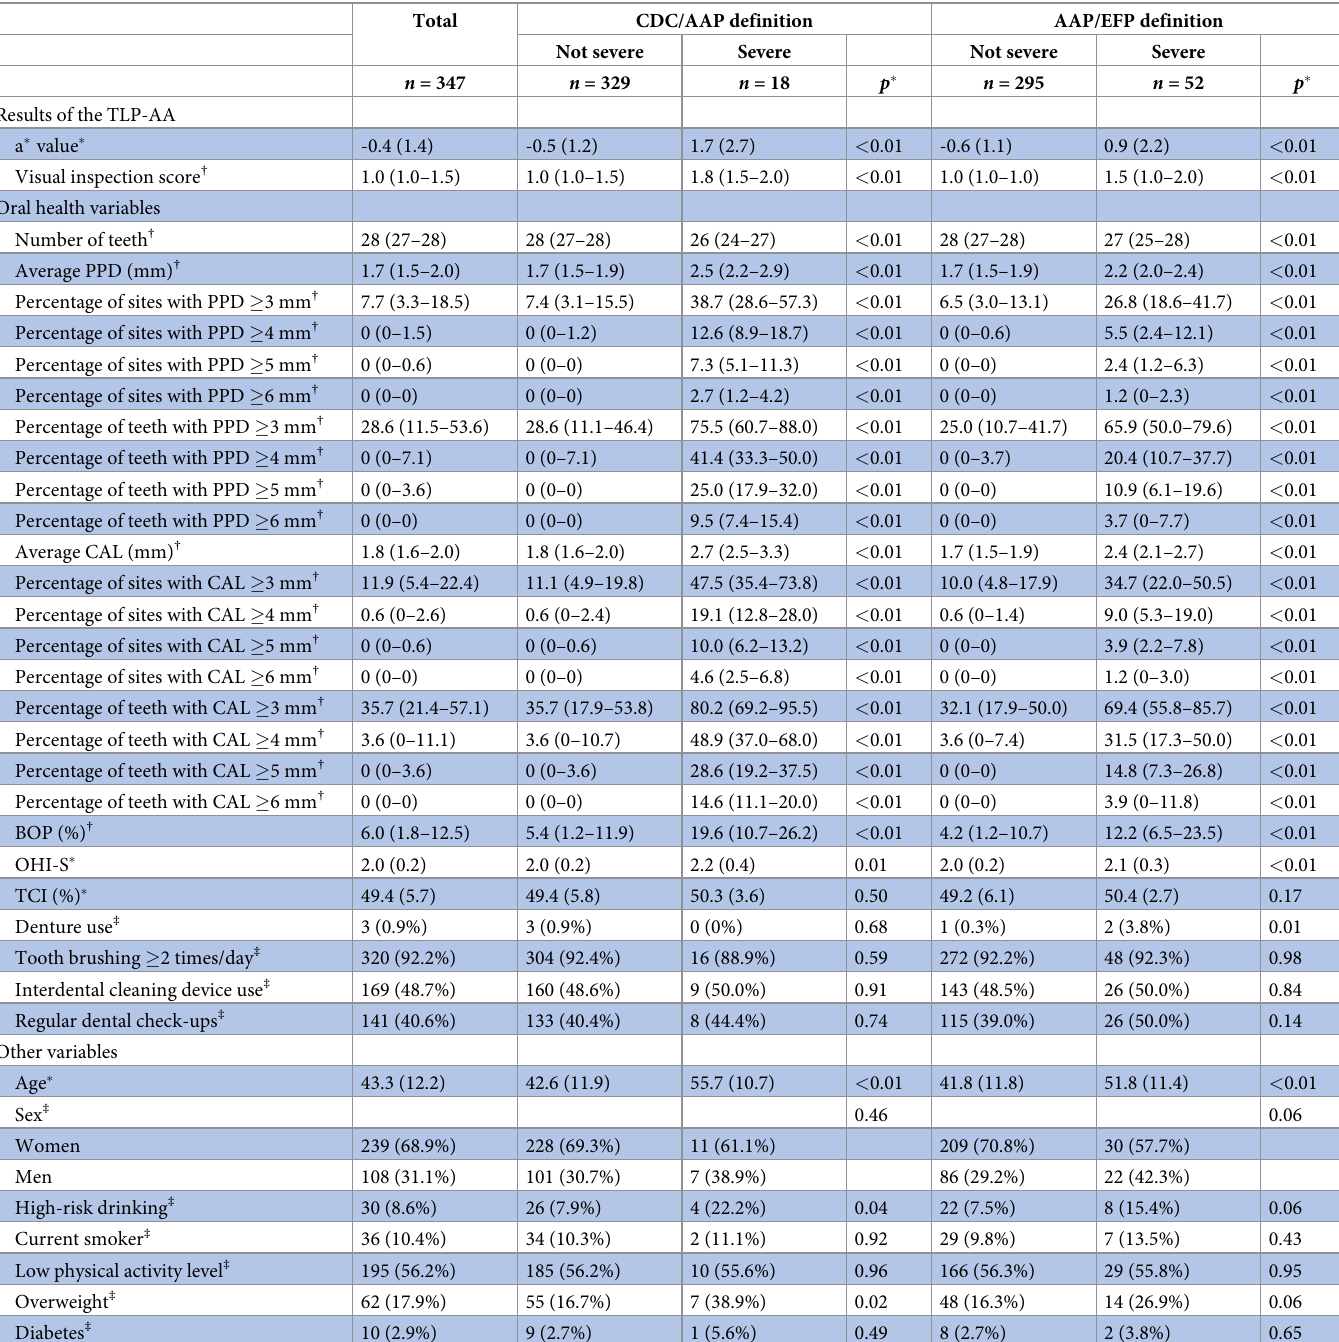
Table 1. Characteristics of the study population according to periodontitis